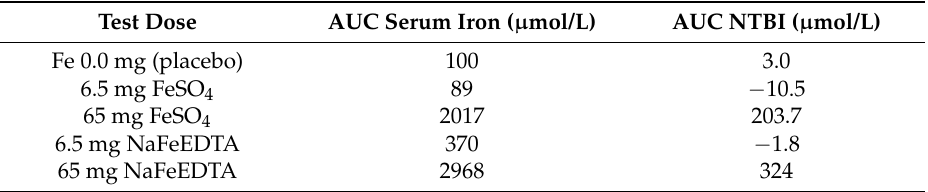
Table 1. Area under the curve (AUC) of serum iron and NTBI during 300 min after